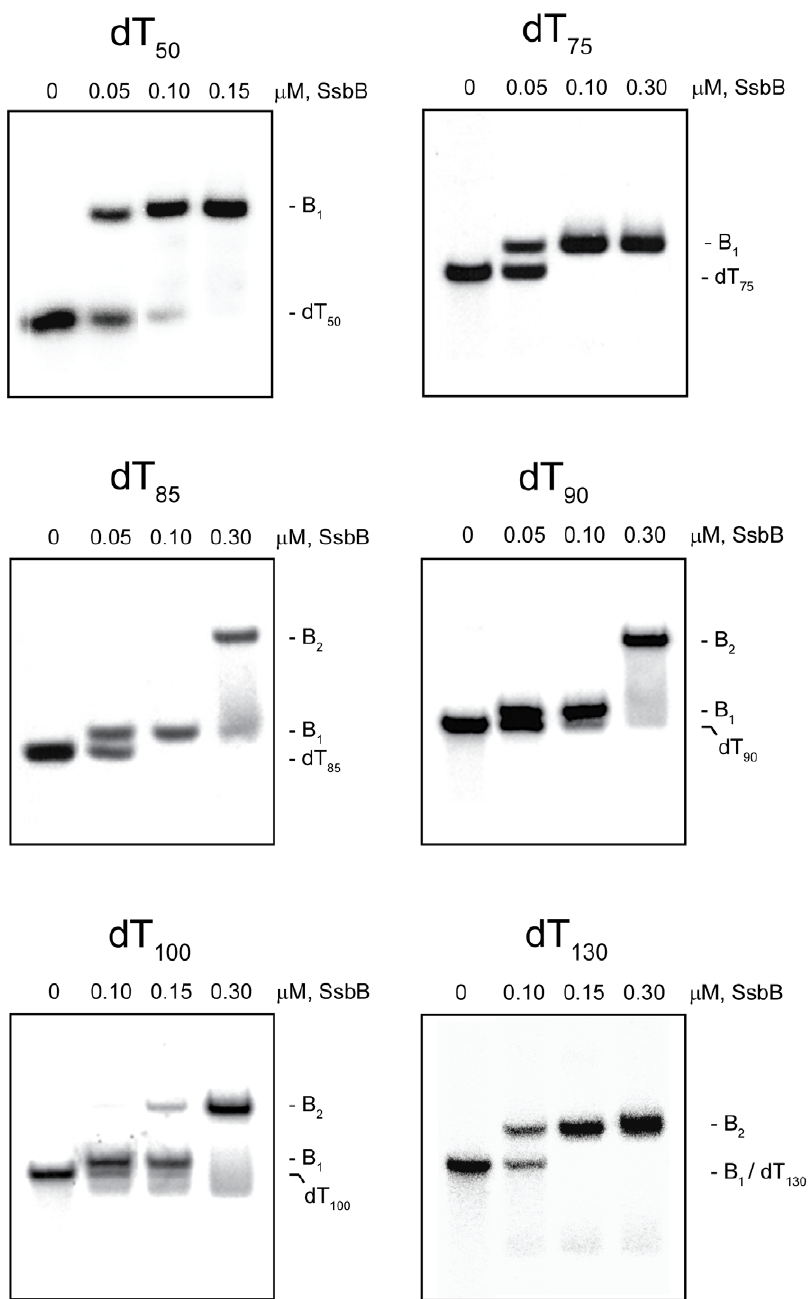
Figure 4. Binding of SsbB protein to dT n oligomers in the absence of Mg 2 + . The reaction solutions contained 25 mM Tris acetate (pH 7.5), 5 m M dT n (nucleotide concentration), and the indicated concentrations of SsbB protein (tetramer concentrations). The reactions were analyzed by polyacrylamide gel electrophoresis using a gel running buffer consisting of Tris acetate (pH 7.5). The bands corresponding to the unbound dT n oligomers, and the B 1 and B 2 complexes, were visualized by phosphorimaging. doi:10.1371/journal.pone.0024305.g004 (Figure 7). When an excess concentration of either SsbA or SsbB alone was added to dT 100 , the corresponding A 2 and B 2 complexes were formed as expected. When SsbA and SsbB were added together to dT 100 , however, the A 2 and B 2 complexes were again formed, but no mixed complexes with one SsbA and one SsbB bound to the same dT 100 molecule were detected (as judged by the absence of a new band with a mobility intermediate between that of the A 2 and B 2 complexes). These results indicated that although